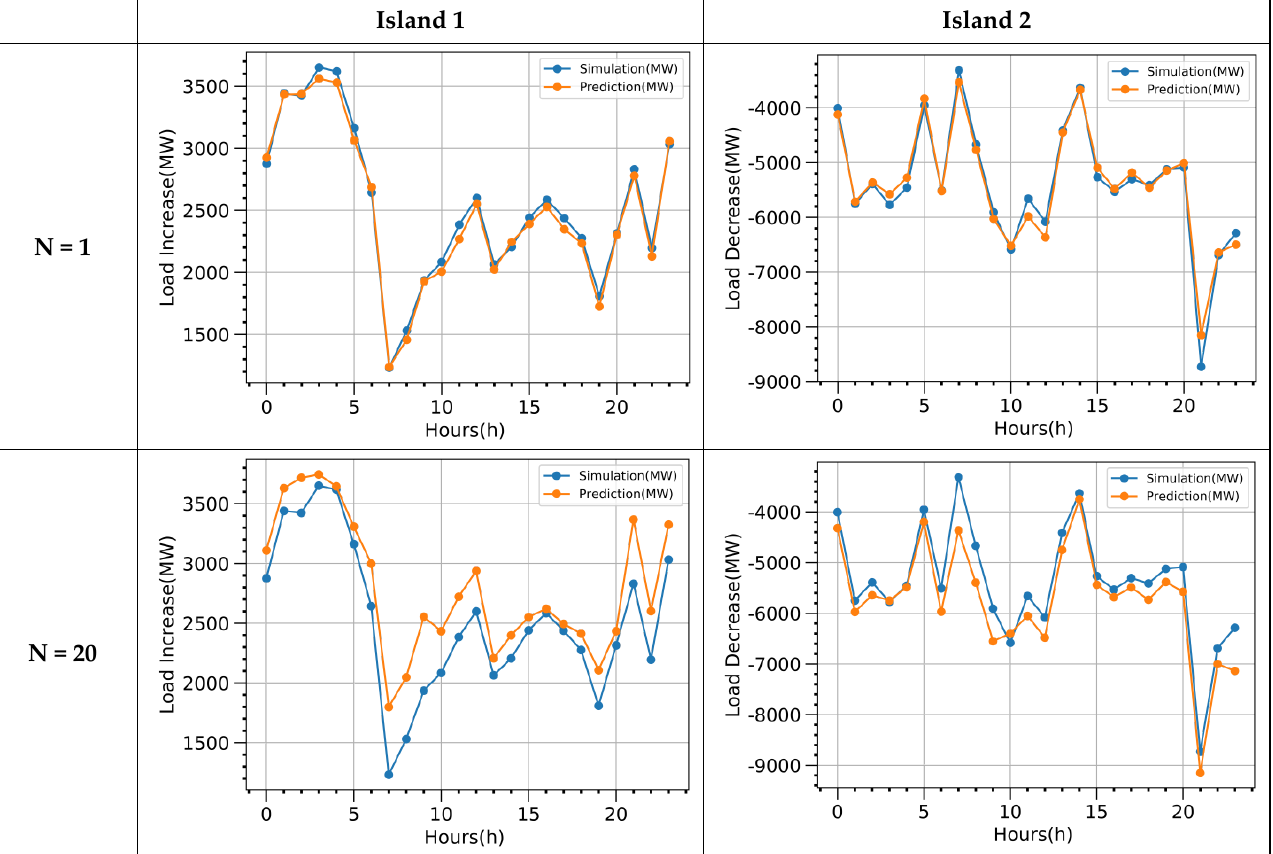
Figure 10. One-day prediction result based on model with penalization and without penalization.